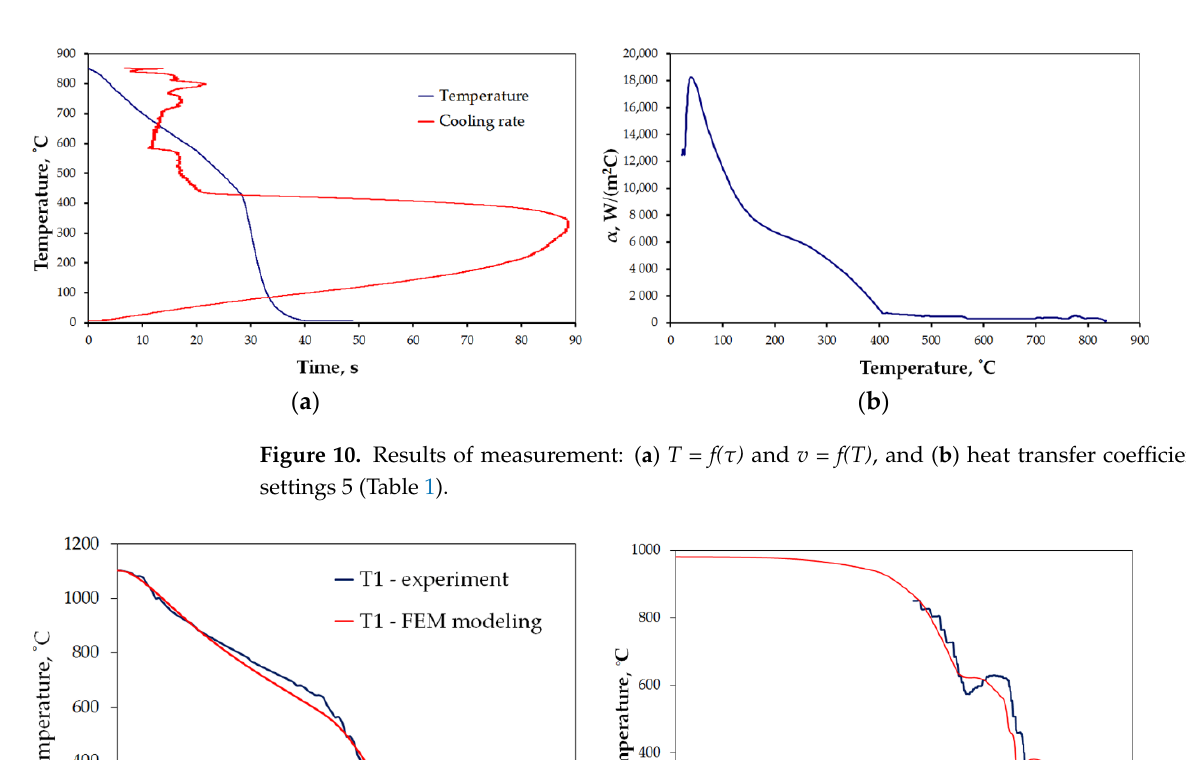
Figure 9. Results of measurement: ( a ) T = f( τ ) and v = f(T) , and ( b ) heat transfer coefficient for settings 4 (Table 1).